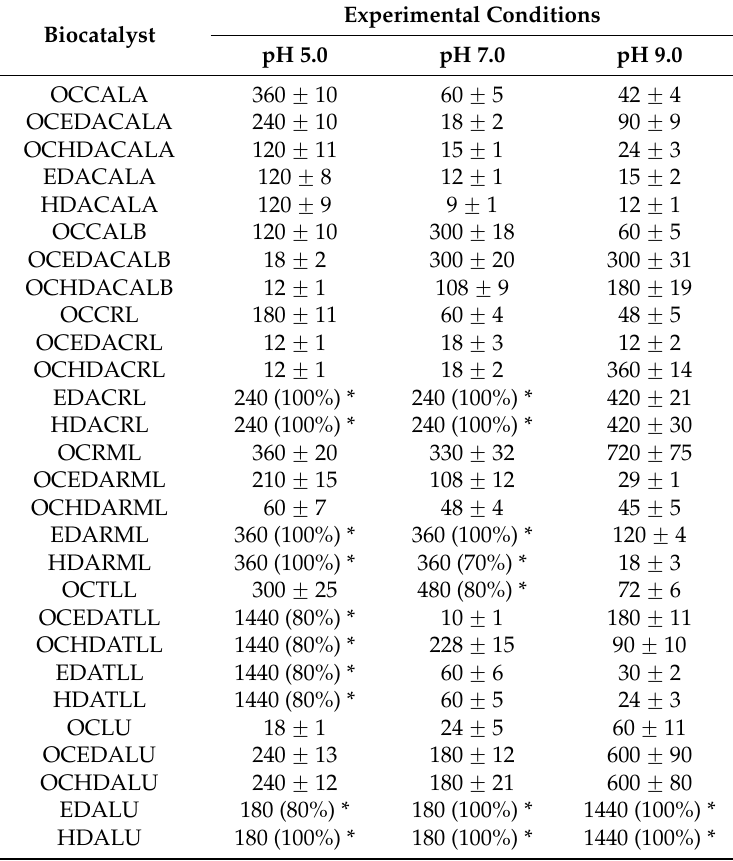
Table 1. Half-lives (in minutes) of the different biocatalysts under different experimental